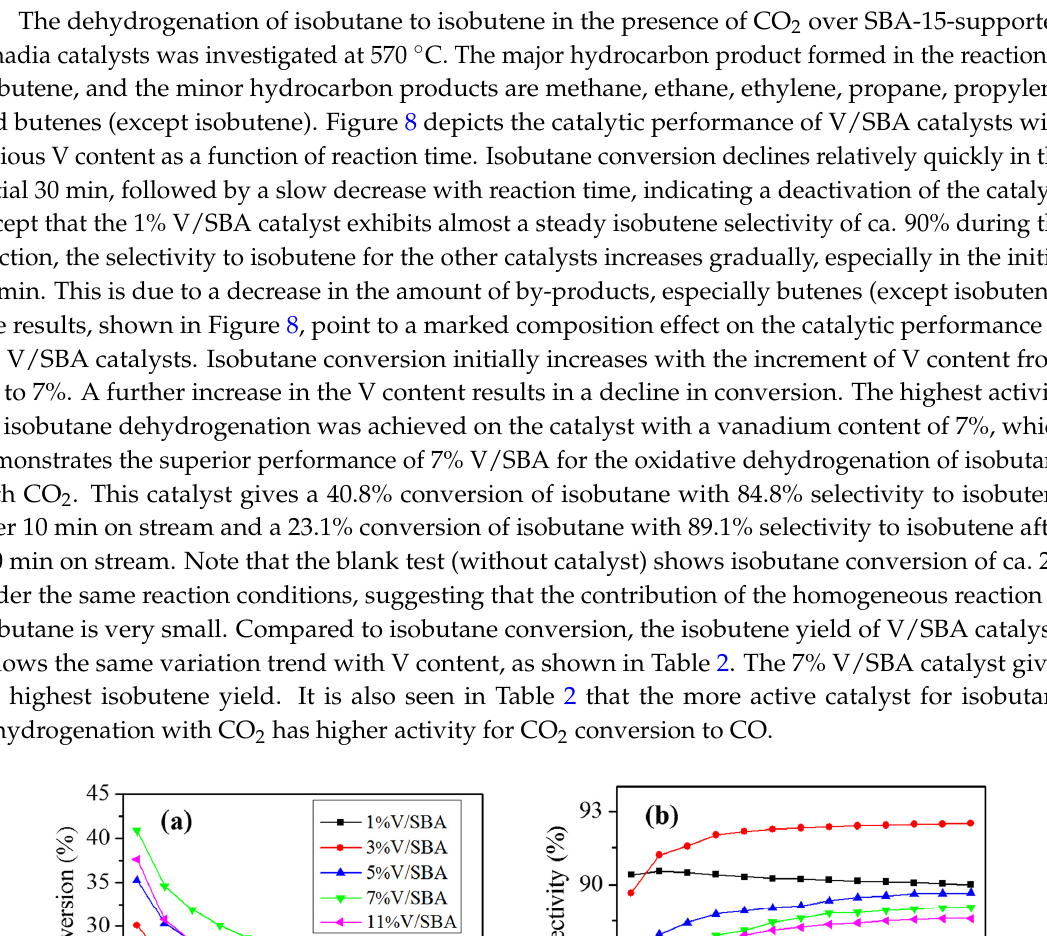
Figure 7. NH 3 ‐ TPD (temperature ‐ programmed desorption) profiles of V/SBA catalysts with different vanadium content. ( a ) 1% V/SBA; ( b ) 3% V/SBA; ( c ) 5% V/SBA; ( d ) 7% V/SBA; ( e ) 7% V/MCM; ( f ) 11% V/SBA.